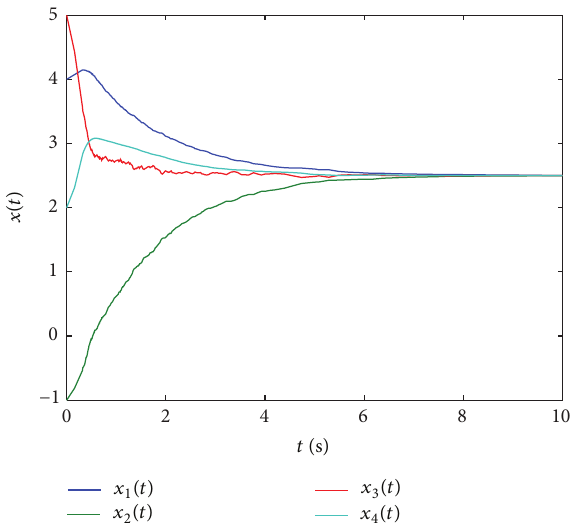
Figure 5: The trajectories of the state vectors 𝑥 1 (𝑡) , 𝑥 2 (𝑡) , 𝑥 3 (𝑡) , and (𝑡) 𝑥 4